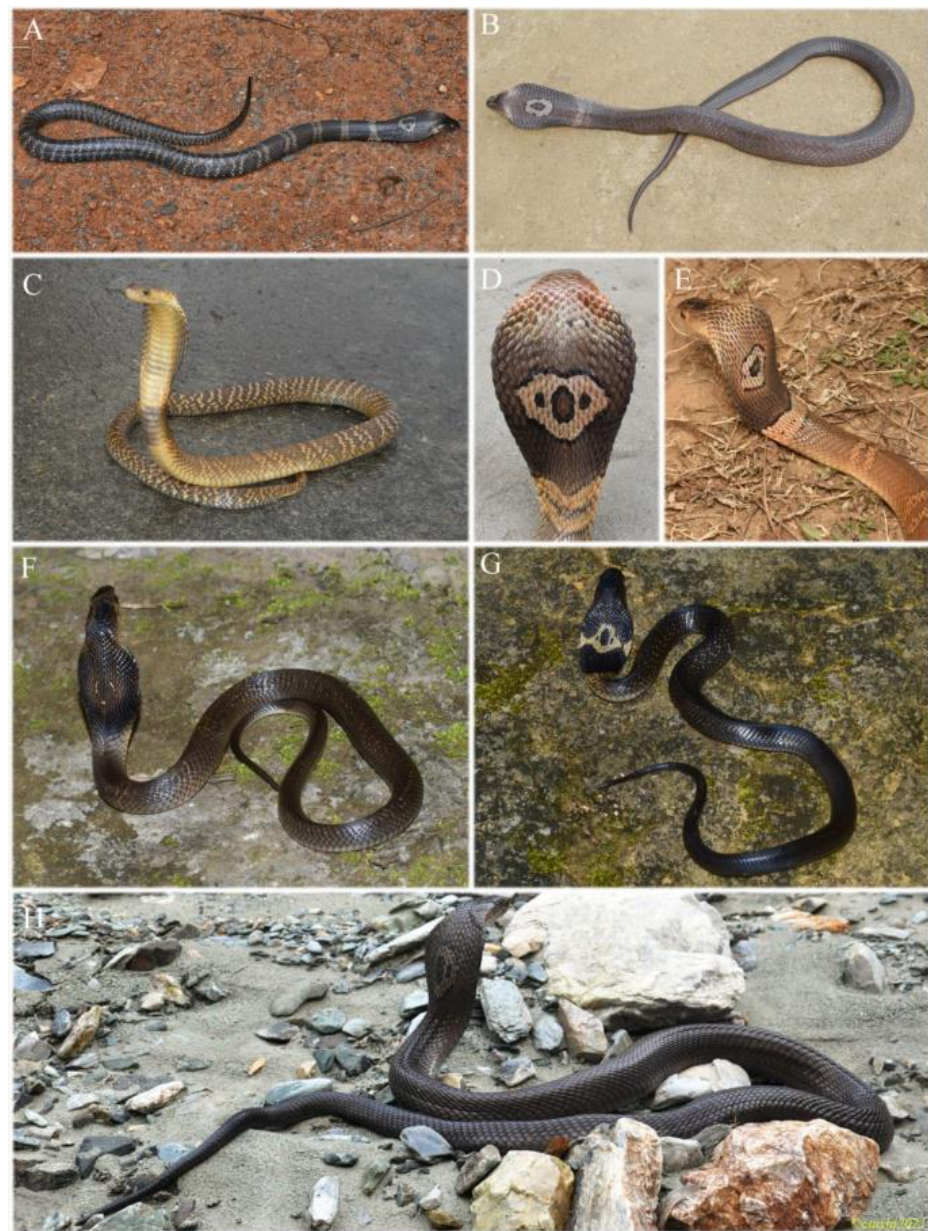
Figure 7. South Asian Naja kaouthia in life. ( A , B ) Two adults from Jhargram, West Bengal, India; ( C ) Individual from Kolkata outskirts of West Bengal, India; ( D ) Adult from Siliguri, North Bengal region of West Bengal, India; ( E ) Individual from Bhuvneshwar, Odisha, India; ( F , G ) two juveniles from Mizoram, India; ( H ) Individual from Samtse town, Bhutan. (( A – E ) photographed by Vivek R Sharma; ( F , G ) photographed by Gernot Vogel; ( H ) photographed by Choggyal Taz). The Southeastern Asian clade is also morphologically different across regions in col‑ oration. Adults from Thailand and peninsular Malaysia are light brown, the population from southern Vietnam is deep brown; juveniles usually darker, blackish brown, olive brown, or light brown (Figure 8). Ventrals of South Asian population 168–186 (177.8 ± 4.9, n = 18); subcaudals 49–58 (54.7 ± 2.4, n = 18); scale rows at anterior body 25–31 (27.0 ± 1.9, n = 20), mid‑body 20–23 (21.2 ± 0.7, n = 19), posterior body 15–17 (15.4 ± 0.8, n = 19); venom spitting behavior was not observed [17,50].